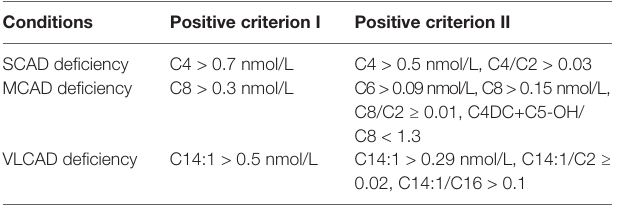
TABLE 1 | Indicators and positive criteria used for ACAD deficiencies in expanded newborn screening.